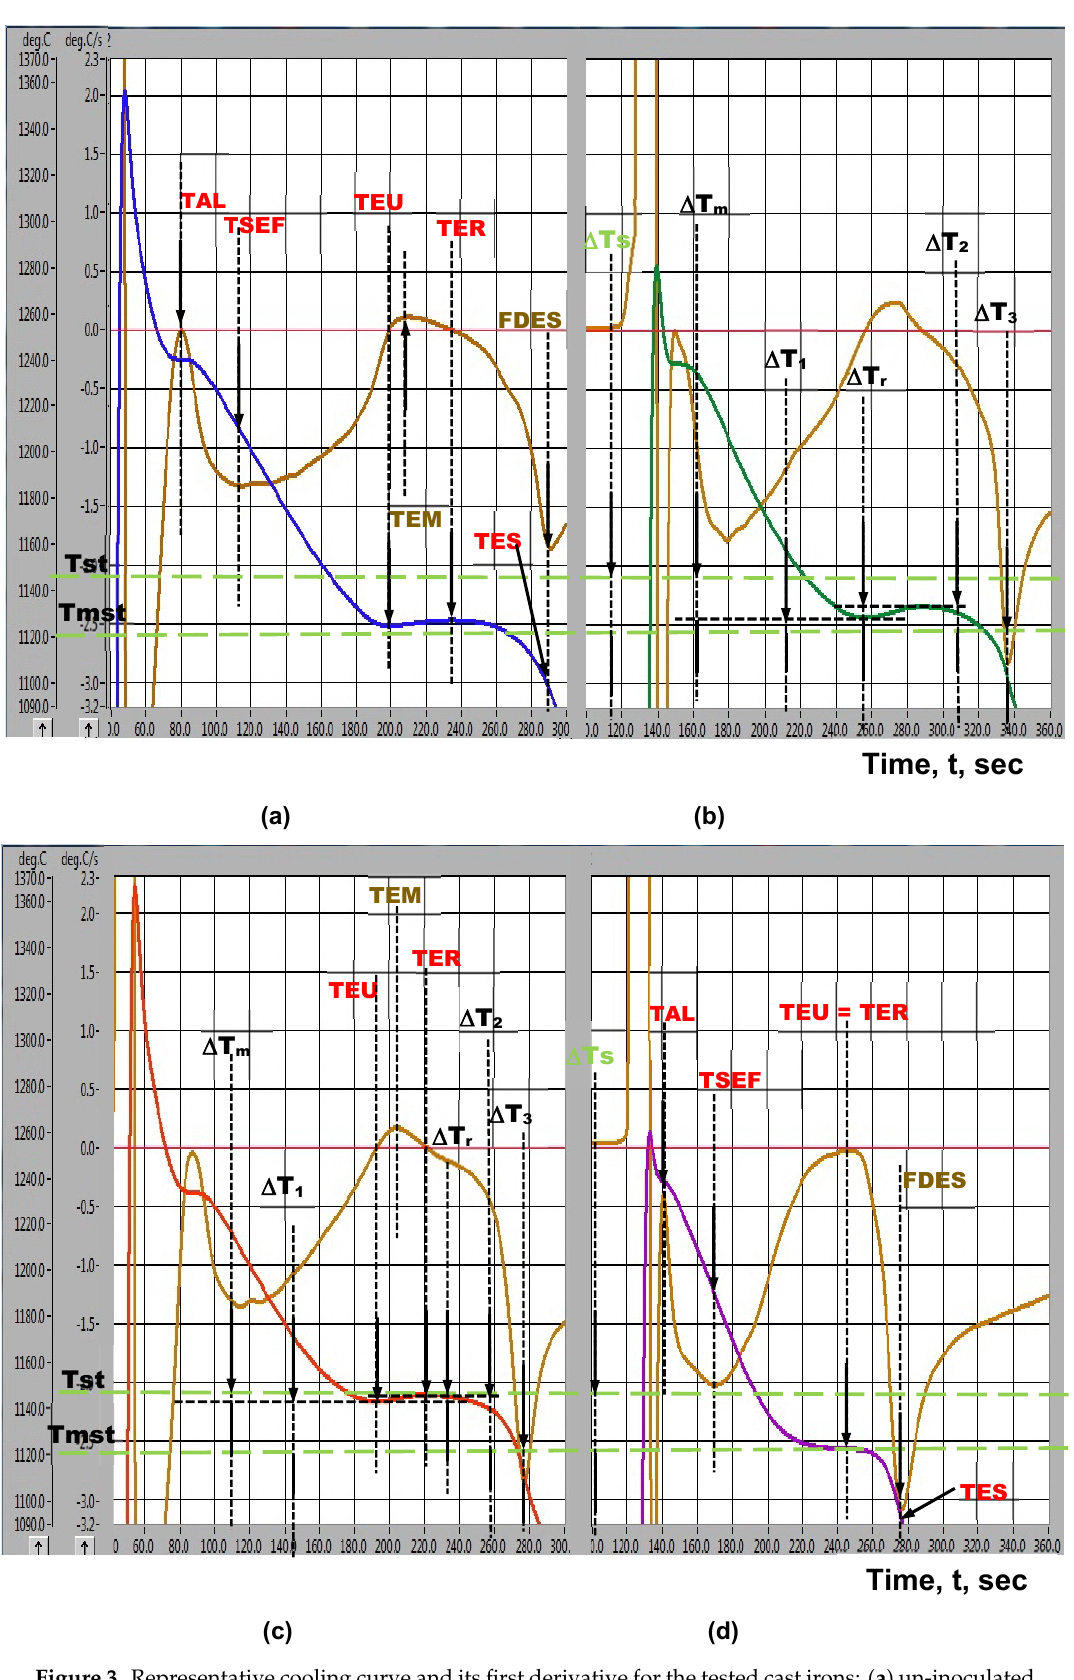
Figure 3. Representative cooling curve and its first derivative for the tested cast irons: ( a ) un-inoculated iron; ( b ) inoculated iron (0.15 wt.% alloy); ( c ) over-inoculated iron (1.2 wt.% alloy); ( d ) Te-added iron.